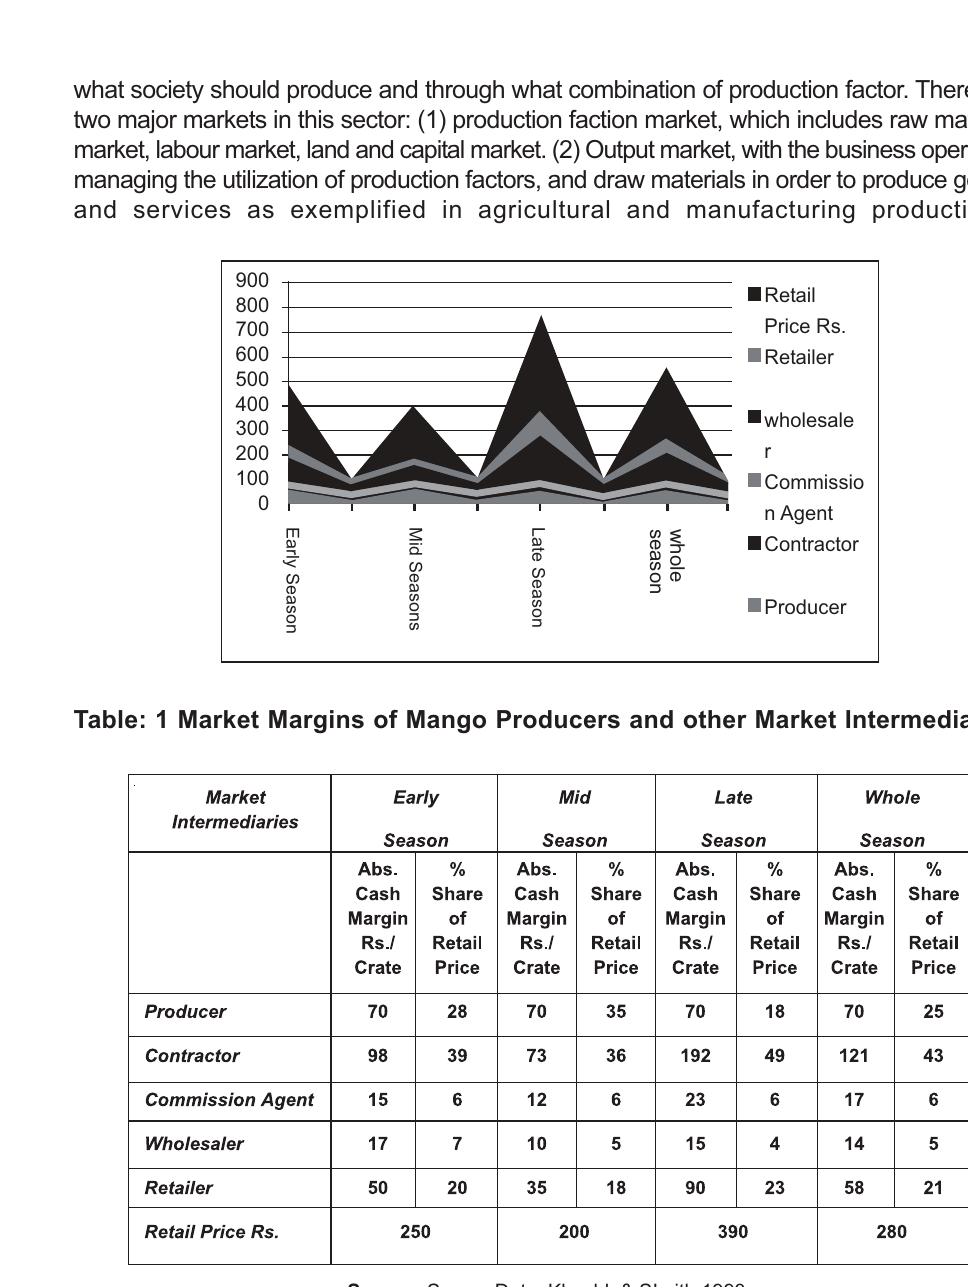
Source: Survey Data, Khushk & SImith